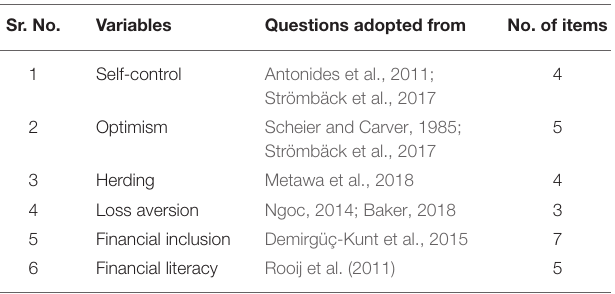
TABLE 1 | Previous research glimpses.